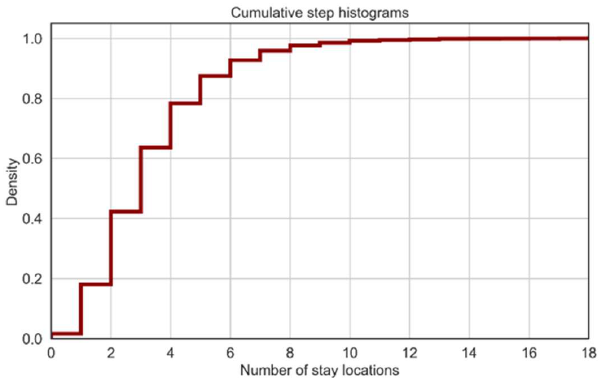
Figure 9. Distribution of number of stay locations per user.